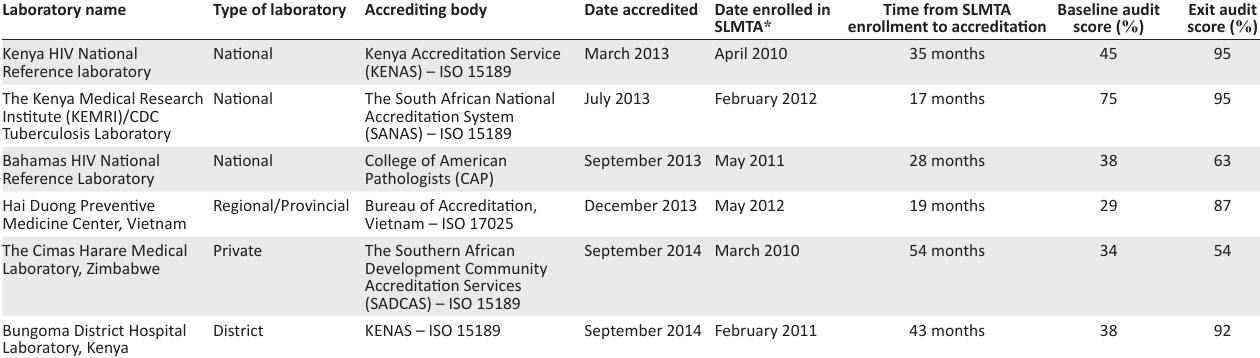
FIGURE 3: Baseline and exit scores by laboratory type for the 302 laboratories completing the Strengthening Laboratory Management Toward Accreditation programme 2010–2013 based on the Stepwise Laboratory Quality Improvement Process Towards Accreditation checklist. TABLE 3: Strengthening Laboratory Management Toward Accreditation laboratories that have achieved formal accreditation as of September